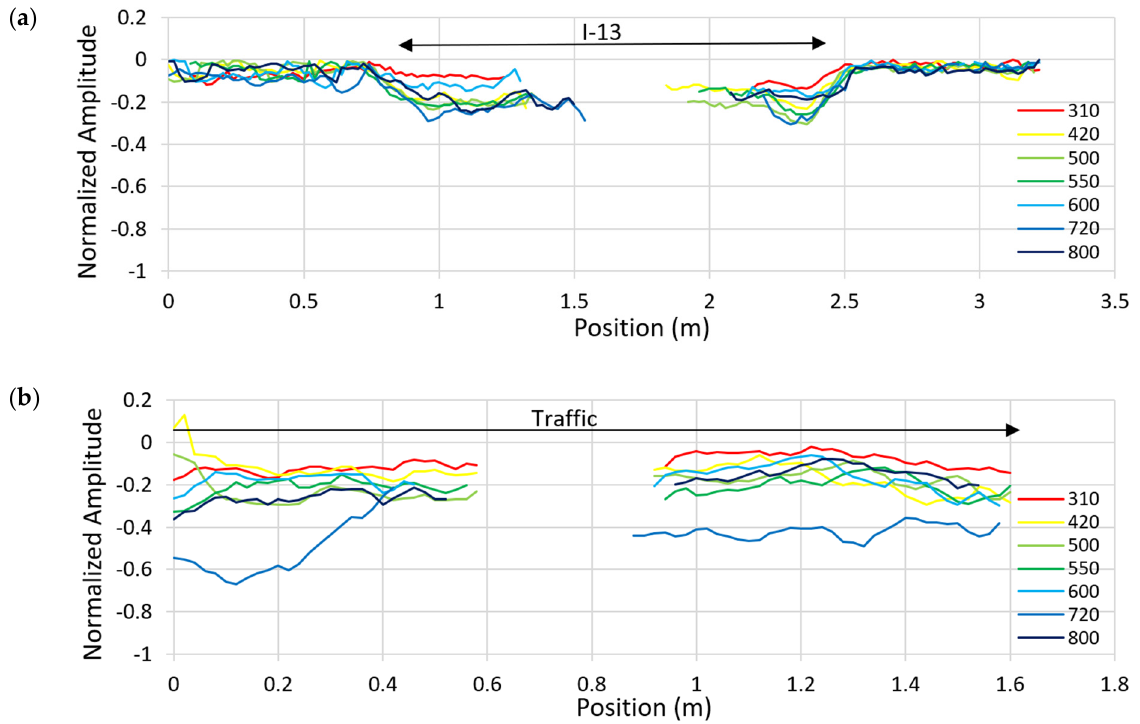
Figure 21. 5 GHz Norm. RW amplitudes on tack-coat free (I-13) in the ( a ) long. and ( b ) transv. direction vs. K loadings. 3.4. Direct Waves in the Zone I-11 to I-13 at 2.6 GHz Similarly, DW amplitudes are picked on the B-scans for each defect and are then normalized by averaged values of DW coming from the healthy zone, outside the